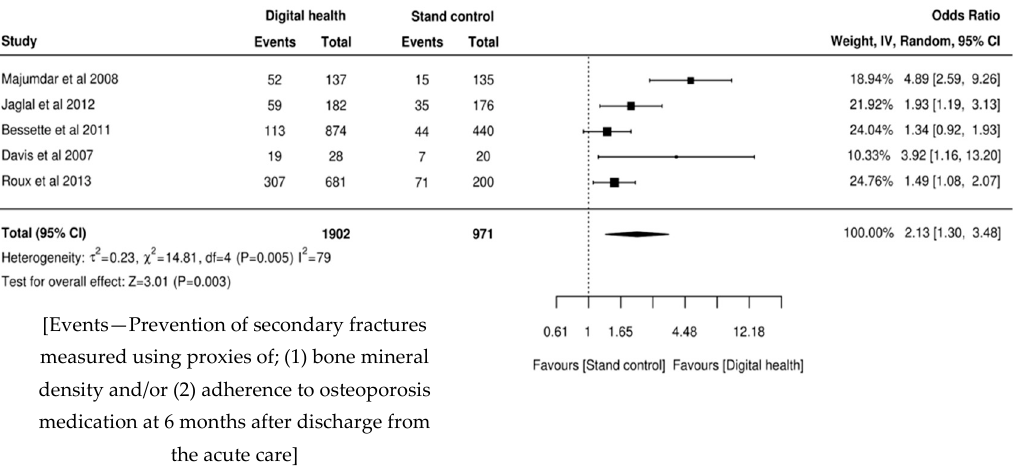
Figure 2. Forest plot.